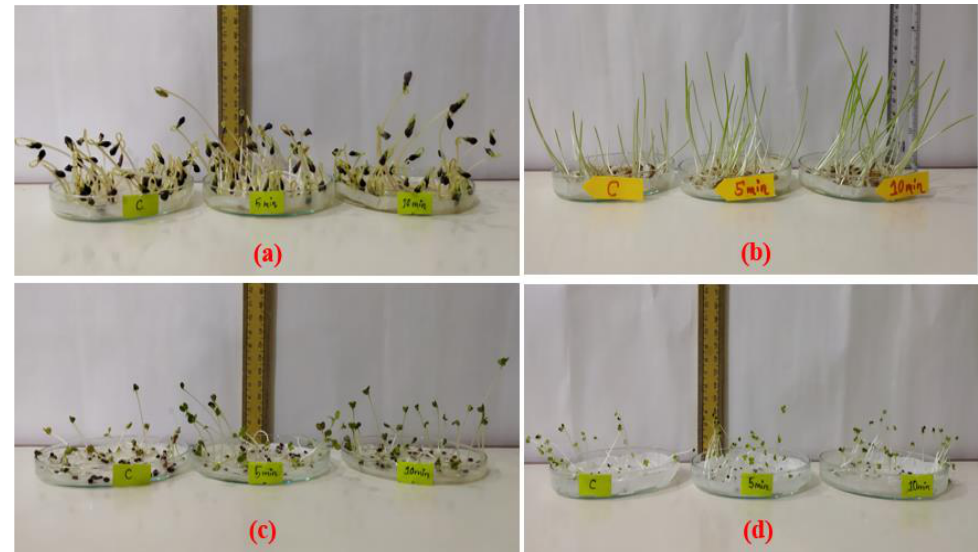
Figure 2. Germination of ( a ) phapar, ( b ) barley, ( c ) mustard, and ( d ) rayo seeds sown in a petri dish irrigated with DI water and PAW (5 and 10 min).